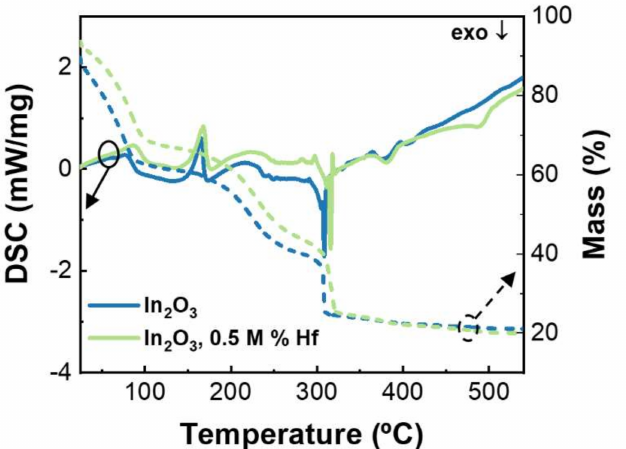
Figure 1. TG-DSC analysis of the undoped and 0.5 M% Hf-doped indium oxide precursor